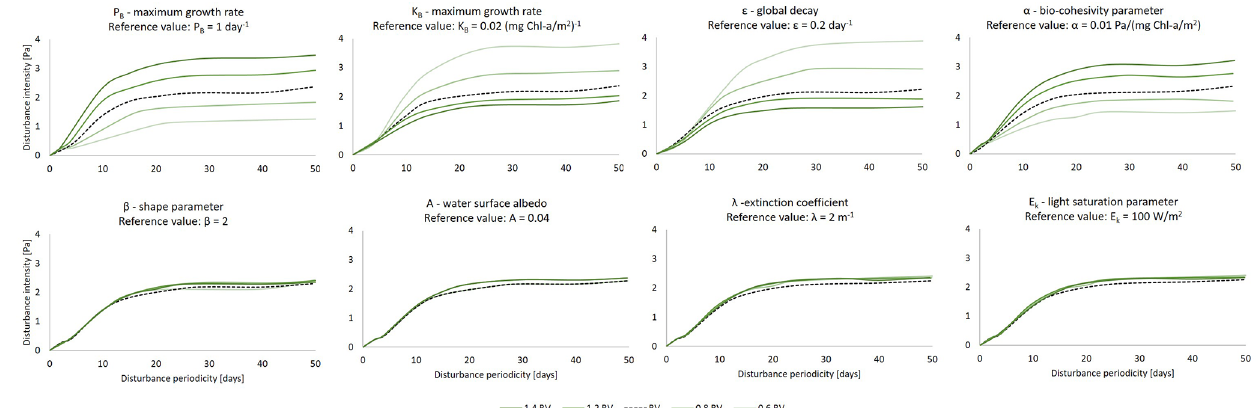
Figure 3. Sensitivity analysis of the model parameters for the determination of the equilibrium configuration. The dashed black line repre- sents the simulation considering the reference value (RV, Table 2), dark green lines represent conditions of the parameters under examination above the reference value (1.2 and 1.4 times the reference value, respectively), and light green lines represent conditions below the reference value (0.8 and 0.6 times the reference value). The area below the curves represents conditions of stable biofilm.